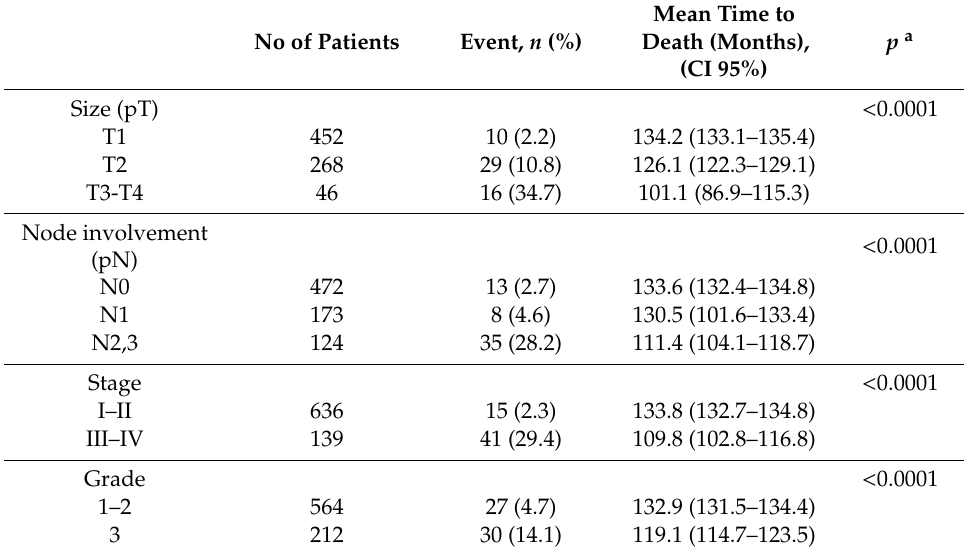
Figure 1. Kaplan–Meier plots according to mode of breast cancer detection: ( a ) Time to relapse (local and/or distant recurrence); ( b ) time-to-breast-cancer-specific death. Vertical spikes represent censored patients. p -values from Mantel–Cox log-rank test. NSDBC—non-screen-detected breast cancers, SDBC—screen-detected breast cancers. Table 5. Tumor-associated death in the age range of 50–69-years old.